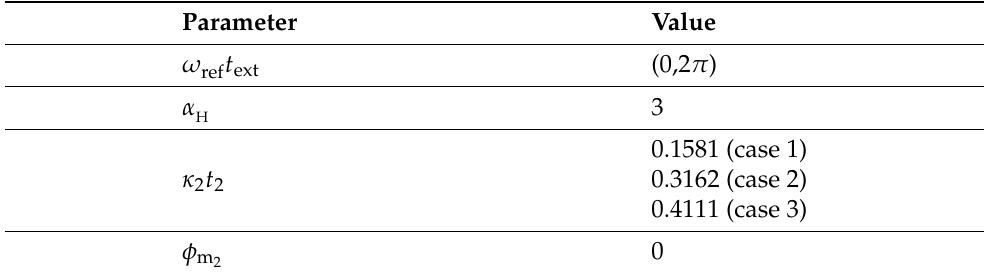
Table 1. Summary of values used in numerical solutions of Equations (5) and